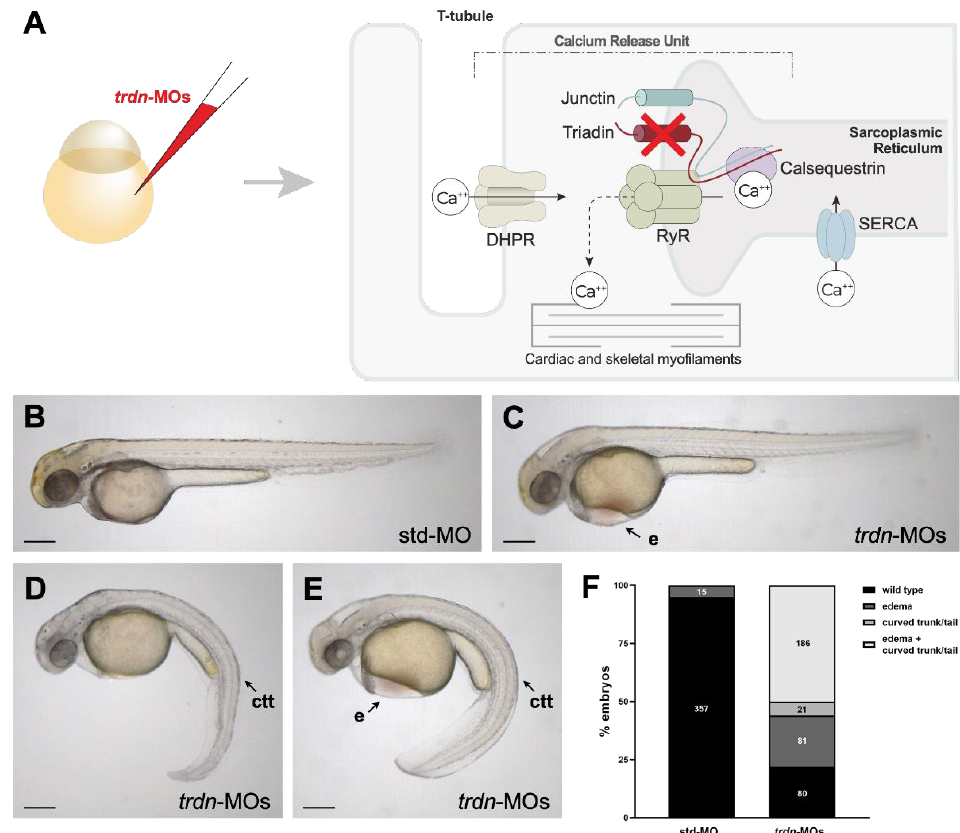
Figure 2. Phenotypical analysis of embryos with trdn loss-of-function. ( A ) Schematic representa- tion of Triadin interactions network and trdn knockdown strategy. RyR: ryanodine receptor; DHPR: dihydropyridine receptor; SERCA: sarco-endoplasmic reticulum calcium ATPase ( B – E ) Representative bright field images of the phenotype of 48 hpf embryos injected with std-MO and trdn -MOs. ( F ) Classification of the phenotypes obtained with trdn -MOs injection. Values indicate the number of embryos for each phenotype. Scale bars indicate 100 μm. e, edema; ctt, curved trunk/tail.